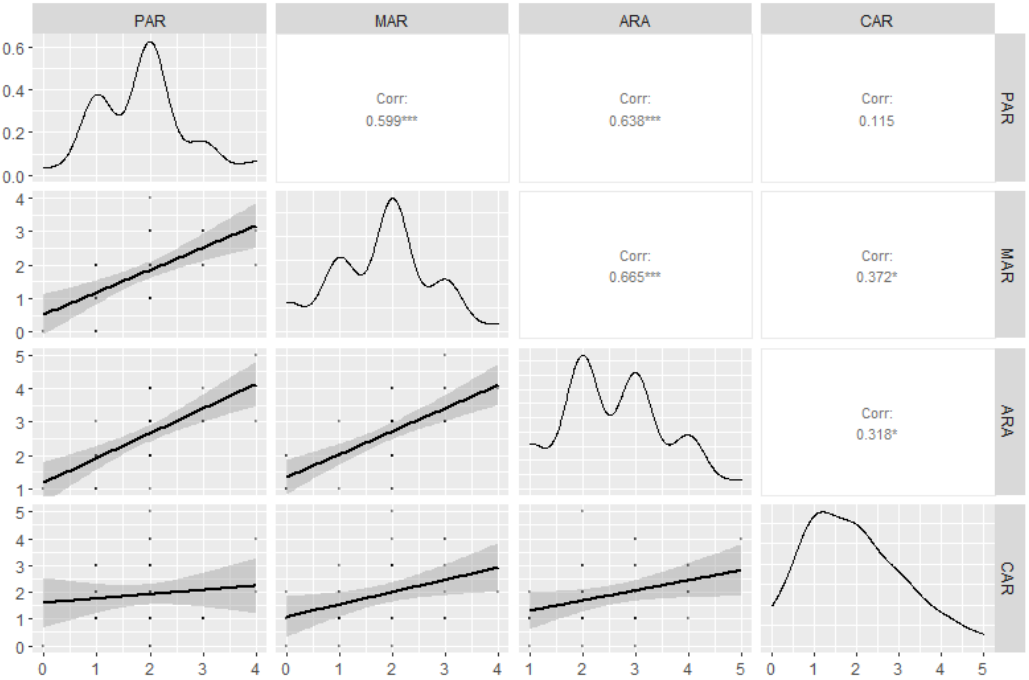
Figure 4: Matrix of plots with significant correlation